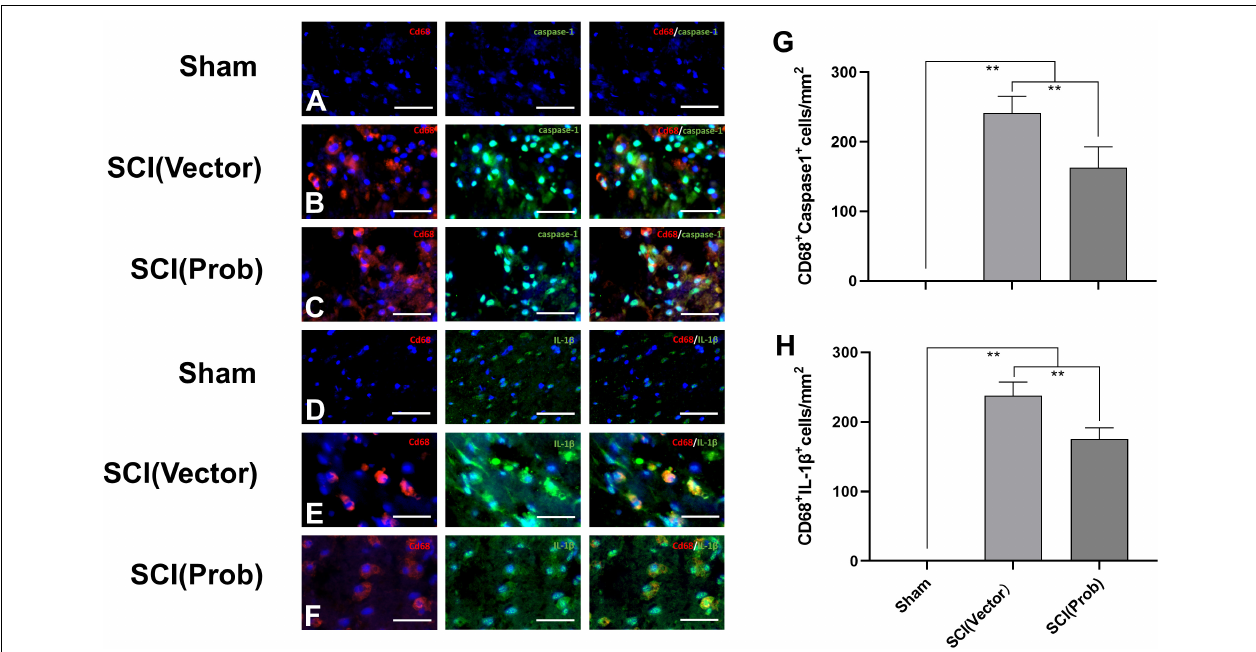
FIGURE 2 | Inhibitory effects of Probenecid on the expression of inflammasome-associated molecules at 7 days following SCI: immunofluorescence detection. Representative images of CD68 (red, rhodamine staining) and caspase-1 [green, fluorescein isothiocyanate (FITC) staining] co-stained (A–C) , CD68 and IL-1 β (green, FITC staining) co-stained (D–F) . Hoechst 33342 (blue) was used to counterstain cells to visualize nuclei. (G,H) Quantitative analysis of CD68 + caspase-1 + (G) , and CD68 + IL-1 β + (H) , (** p < 0.01 n = 6) scale bar: 50 µ m.